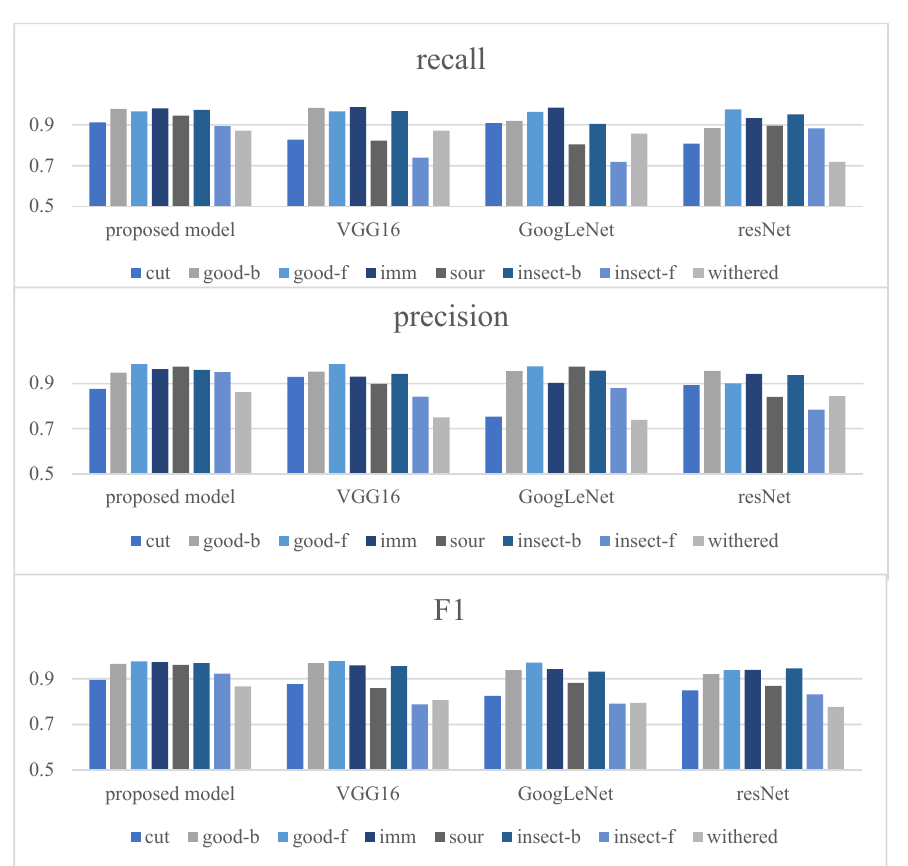
Figure 17. Comparisons of recall, precision and F1 in various models.